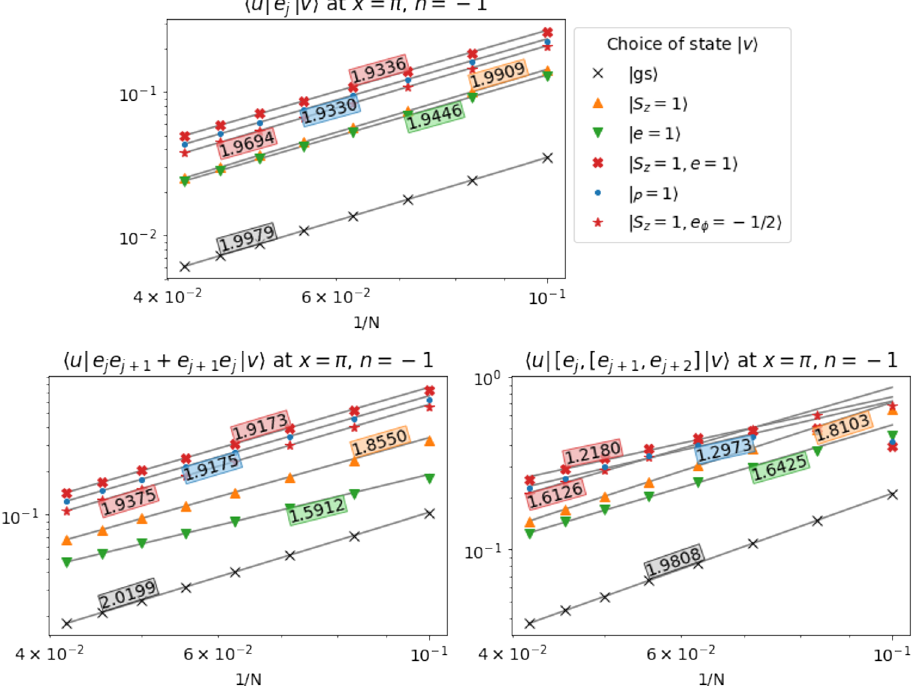
Figure 3 . Absolute value of matrix elements, plotted with logarithmically scaled axes for sizes N = 10 ; 12 ; : : : ; 24. A linear (cid:12)t is performed, excluding the lowest two sizes. The (cid:12)t indicates that the matrix elements decay as O (1 =N r ), where the estimated slope r is shown on each curve. The ground state j gs i is given for the lattice parameters S z = e = e (cid:30) = p = 0. For the other choices of state j v i any non-zero lattice parameter is speci(cid:12)ed, with the others remaining zero. For each state j v i the state j u i corresponds to the same choice of lattice parameters up to a change in momentum sector, p ! p + 1. The lowest energy state for each choice of lattice parameters is used. The absolute values of the matrix elements are independent of j